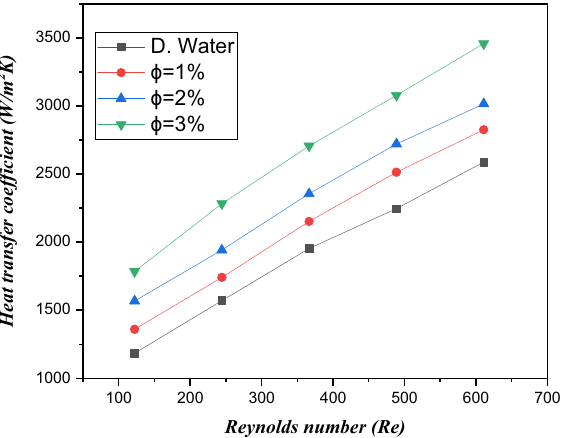
Figure 9. Estimation of the heat transfer coefficient against the Reynolds number in a minichannel heat sink for a microelectronic chip with TiO 2 /water nanofluids and distilled water.